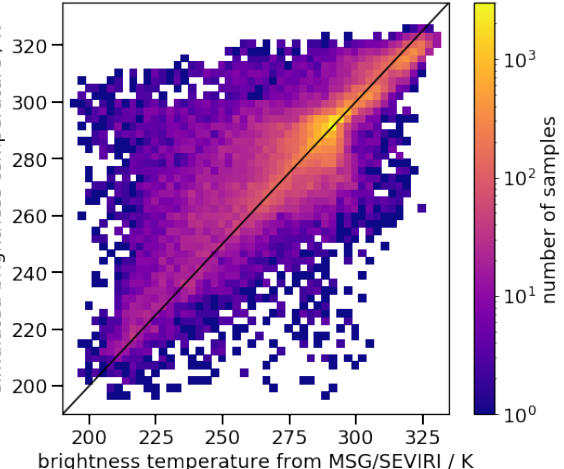
Figure 8. BT 10.8 measured by MSG/SEVIRI against corresponding RTSIM and libRadtran results for the corresponding coordinates.